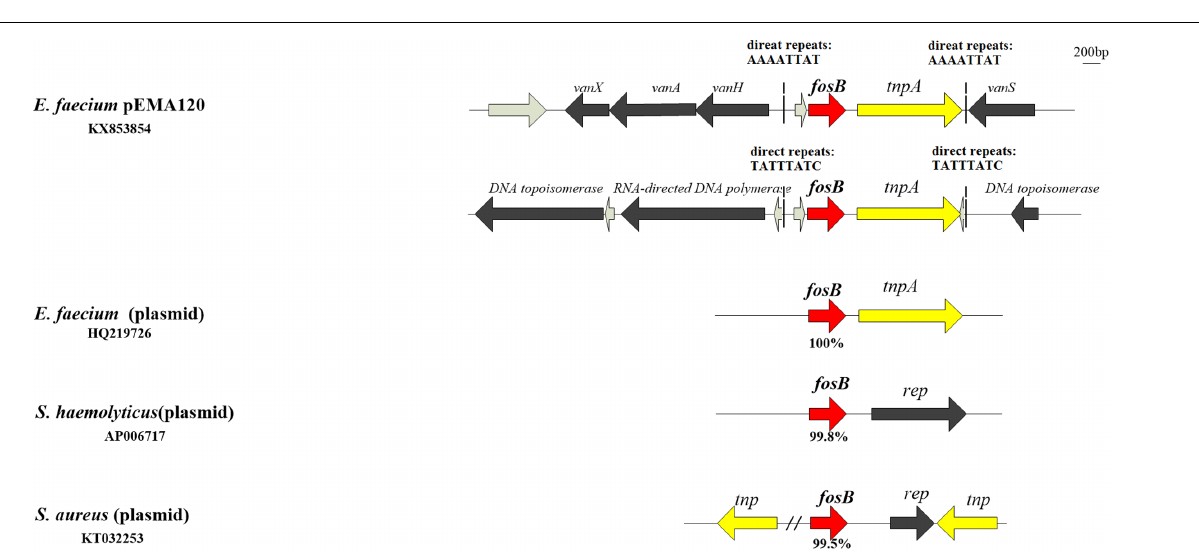
FIGURE 2 | The fosB gene and genetic environment of fosB in different species or genera. fosB genes are indicated by red arrows with nucleotide identity below.